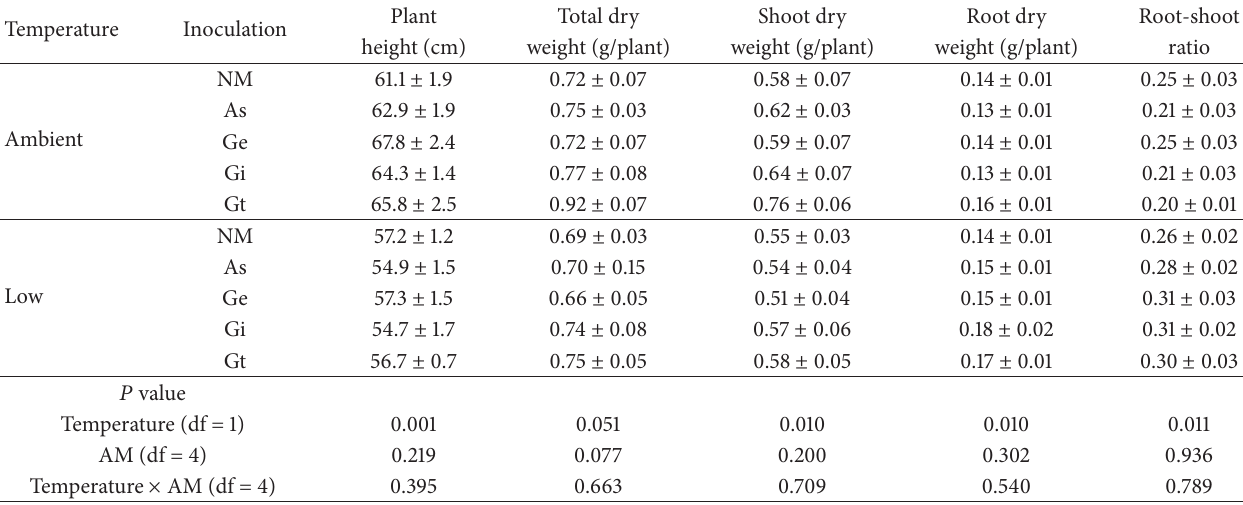
Table 1: Effects of AM on plant height, total dry weight, shoot dry weight, root dry weight, and root-shoot ratio of maize seedlings under ambient temperature and low temperature regimes.